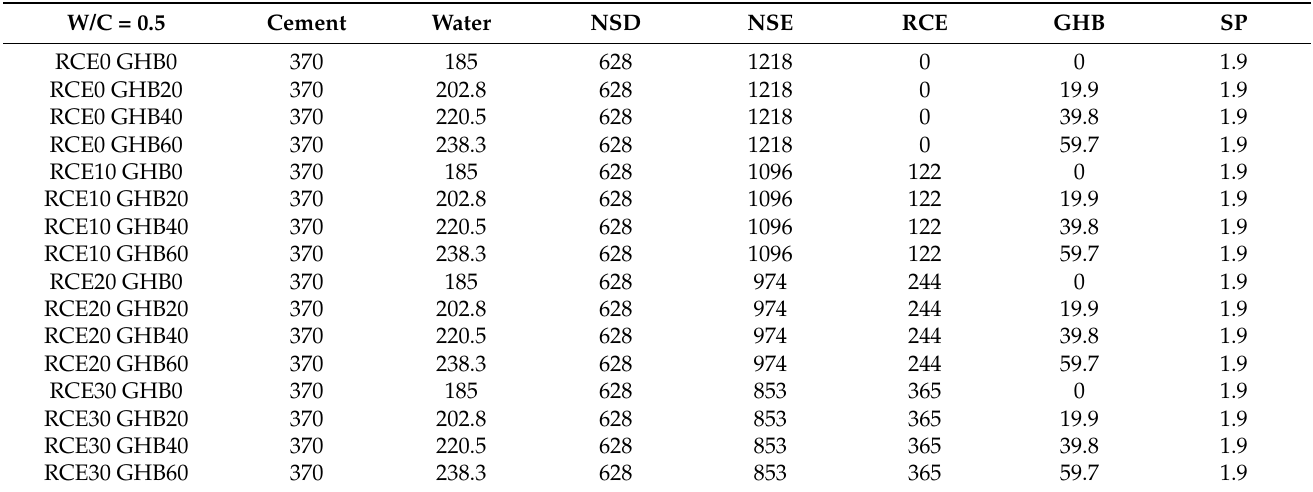
Figure 3. The replacement methods for RCE and GHB. Table 4. Mixing proportions of concrete mixtures (kg/m 3